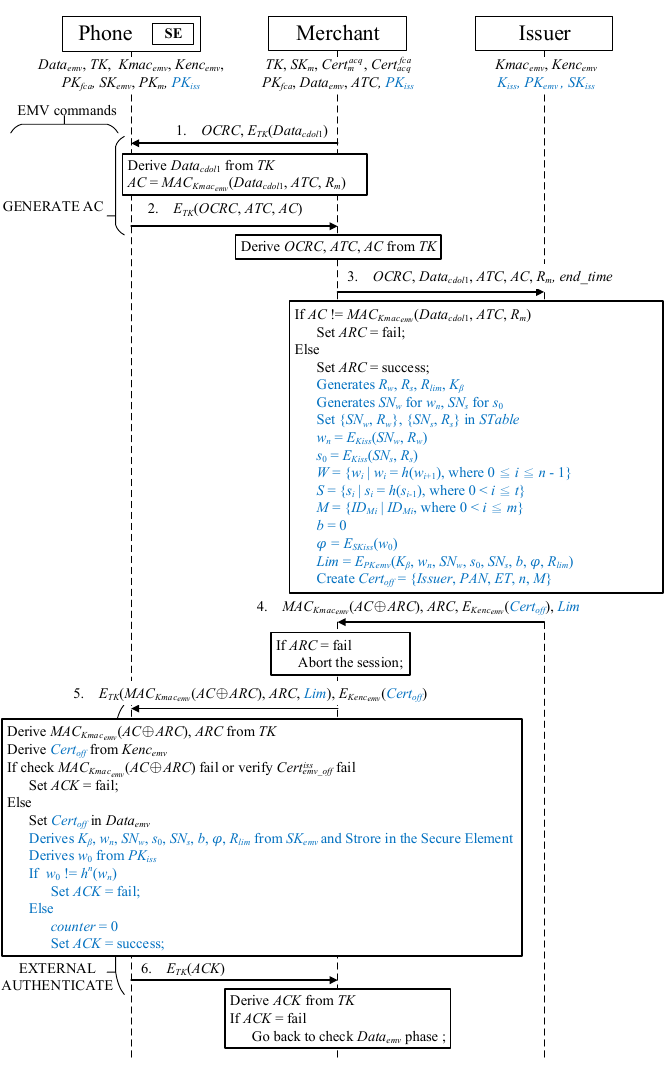
Figure 5. Offline certificate application and split credit line authorization